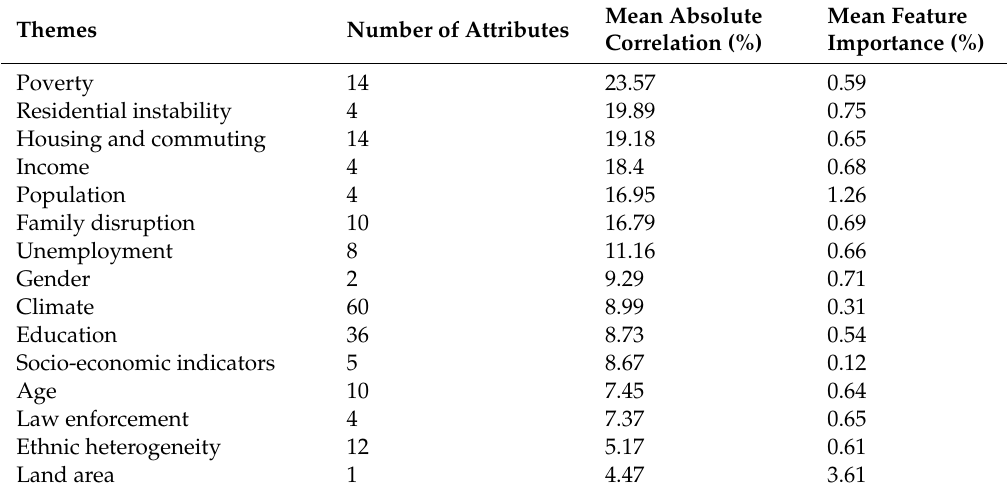
Table 3. Summary of the selected